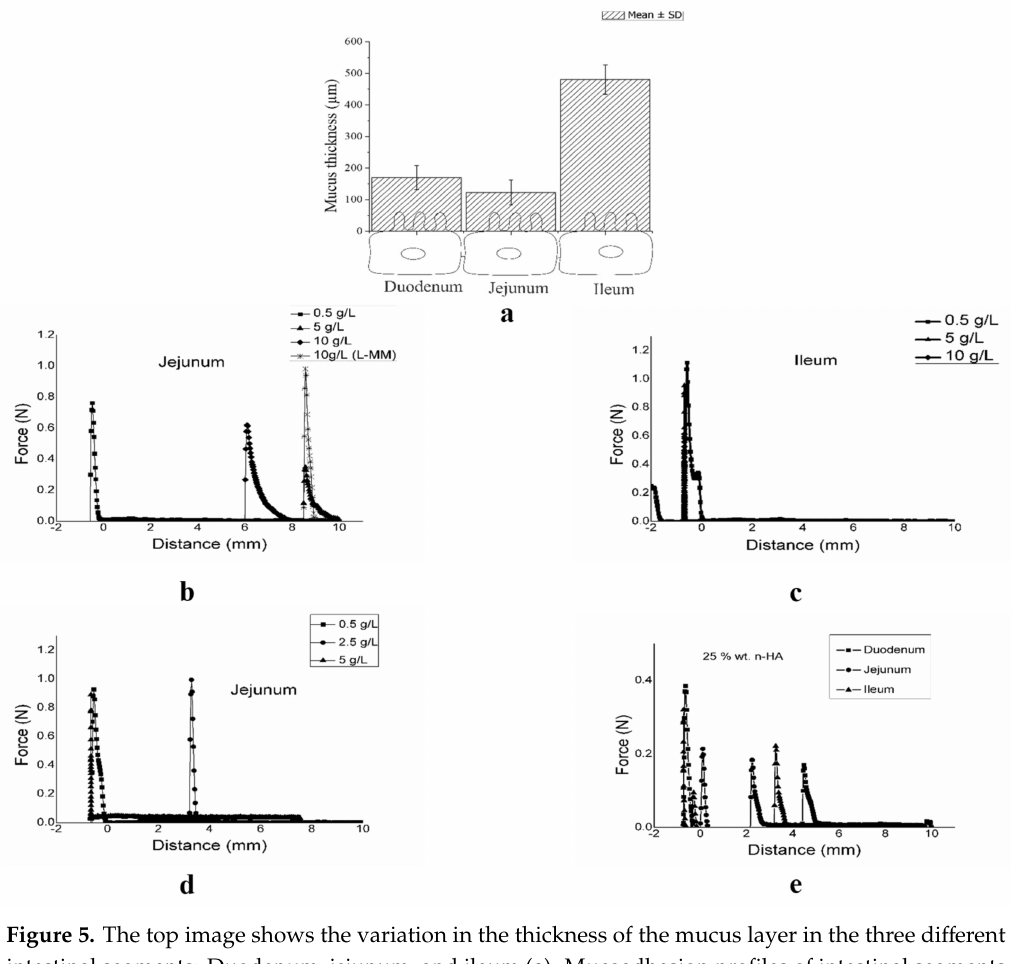
Figure 5. The top image shows the variation in the thickness of the mucus layer in the three di ff erent intestinal segments: Duodenum, jejunum, and ileum ( a ). Mucoadhesion profiles of intestinal segments that present the peak force in the presence of f-HA I-MM ( b ), f-HA H-MM ( c ), f-HA n-HA ( d ), and mixed-HA ( e ). Variations of the force for the detachment of the HA structures adhered to rat intestinal mucosa. The force was a function of upward probe distance for the following compositions: 0.5 g / L ( ), 2.5 g / L ( ), 5 g / L ( ), 10 g / L ( ), 10 g / L hydrolyzed ( ), and 25 wt.% n-HA 10 g / L.